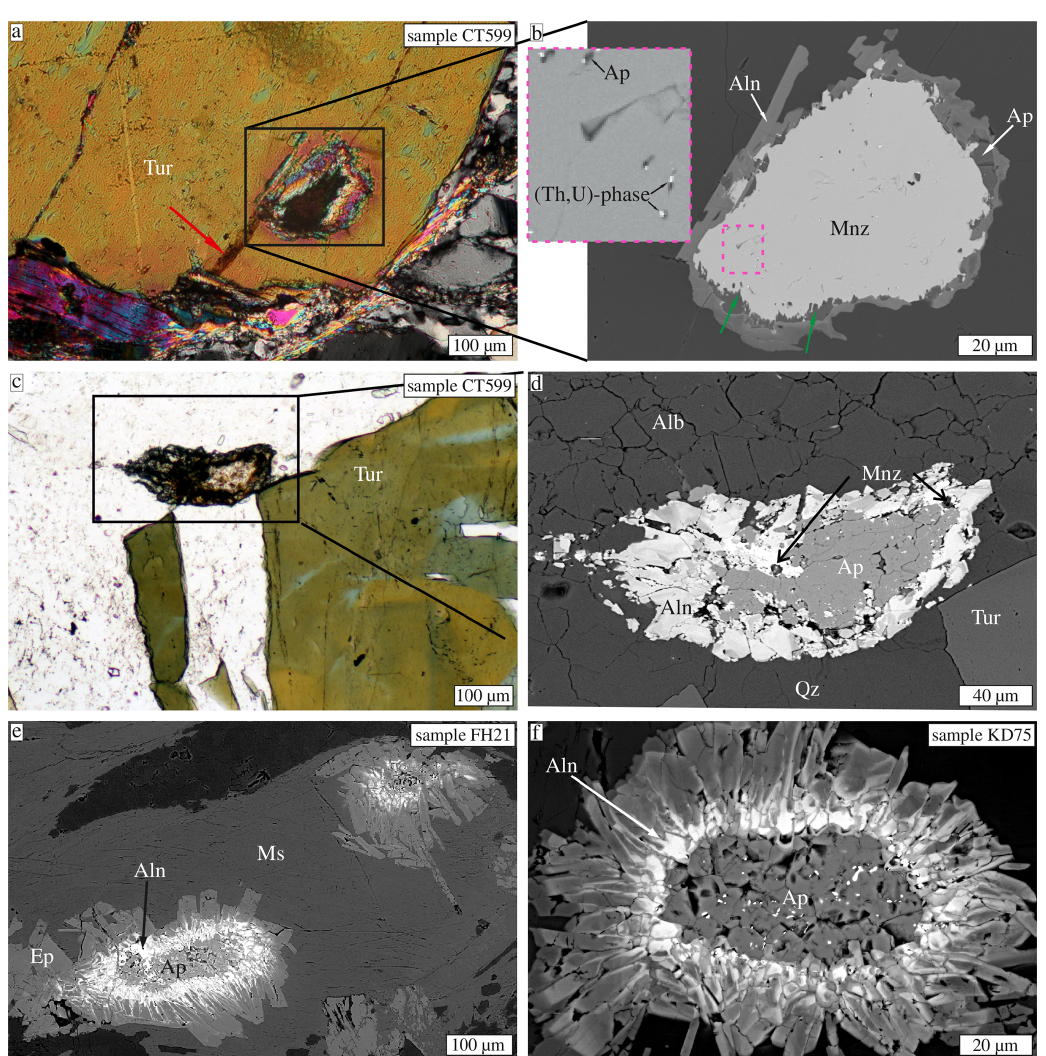
Figure 3. Coronae with varying relative proportions of fluorapatite to monazite. (a) Polarized light micrograph with crossed polarizers showing monazite inclusion in tourmaline located near an intragranular crack (red arrow, sample CT 599). (b) BSE image of monazite inclusion shown in (a) with thin fluorapatite and allanite rim. The inset shows that fluorapatite inclusions in the monazite are associated with (Th,U) phases. (c) Polarized light micrograph and (d) corresponding BSE image showing corona microstructure located at a quartz-filled fracture in tourmaline (sample CT 599). (e, f) Corona microstructures without monazite core. Note especially the prismatic shape of and chemical zoning within the allanite/epidote